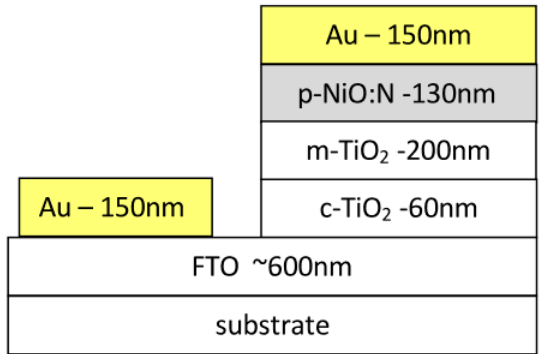
Figure 1. Schematic representation of the fabricated NiO:N/TiO 2 heterodiode (NiO:N/m-TiO 2 /c-TiO 2 /FTO/glass). Thicknesses are not to scale.